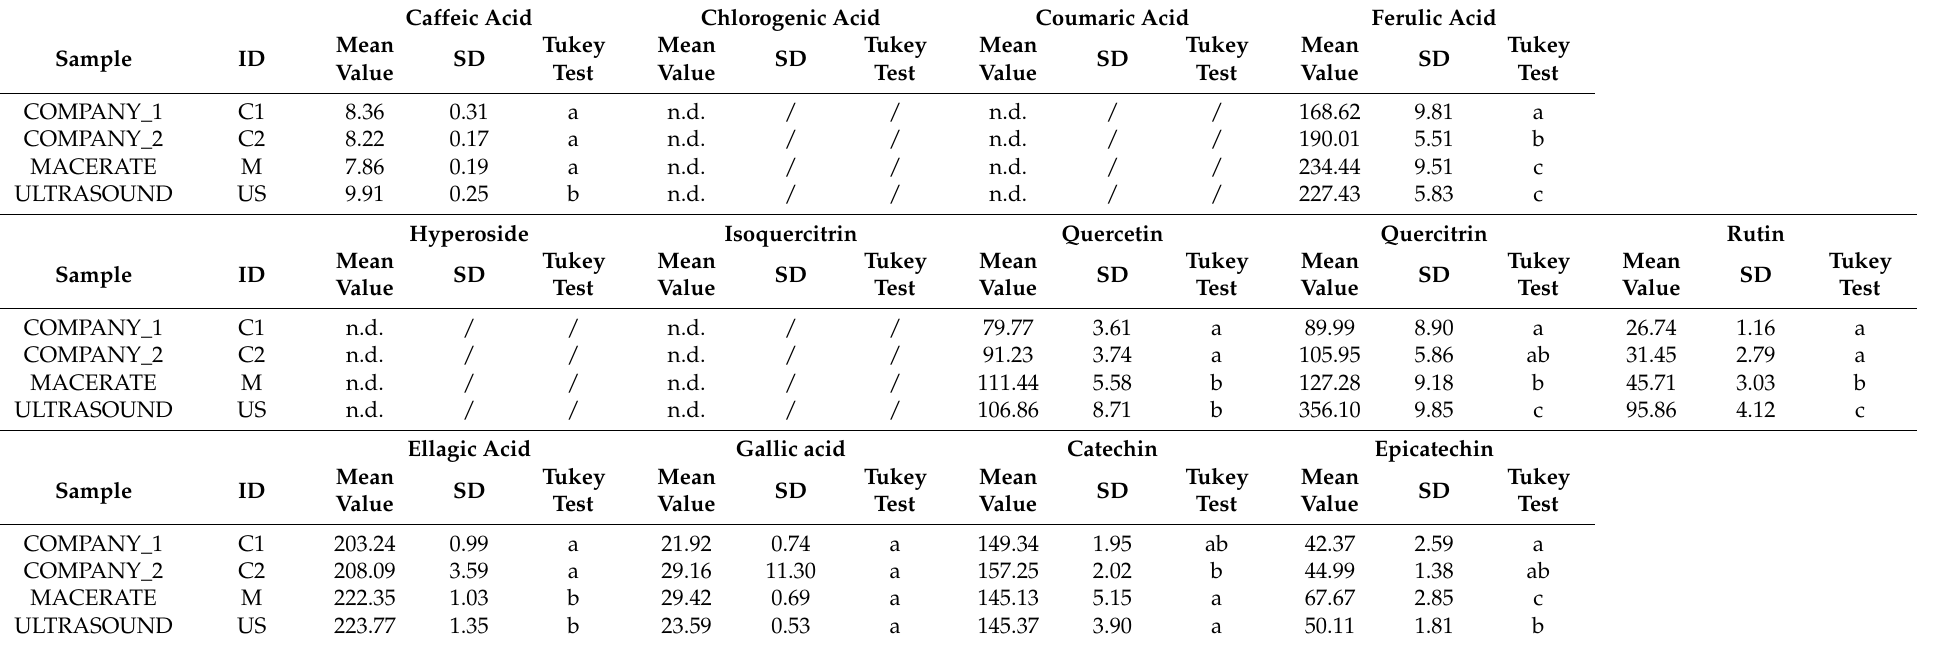
Table 1. HPLC fingerprint of the analysed V. vinifera